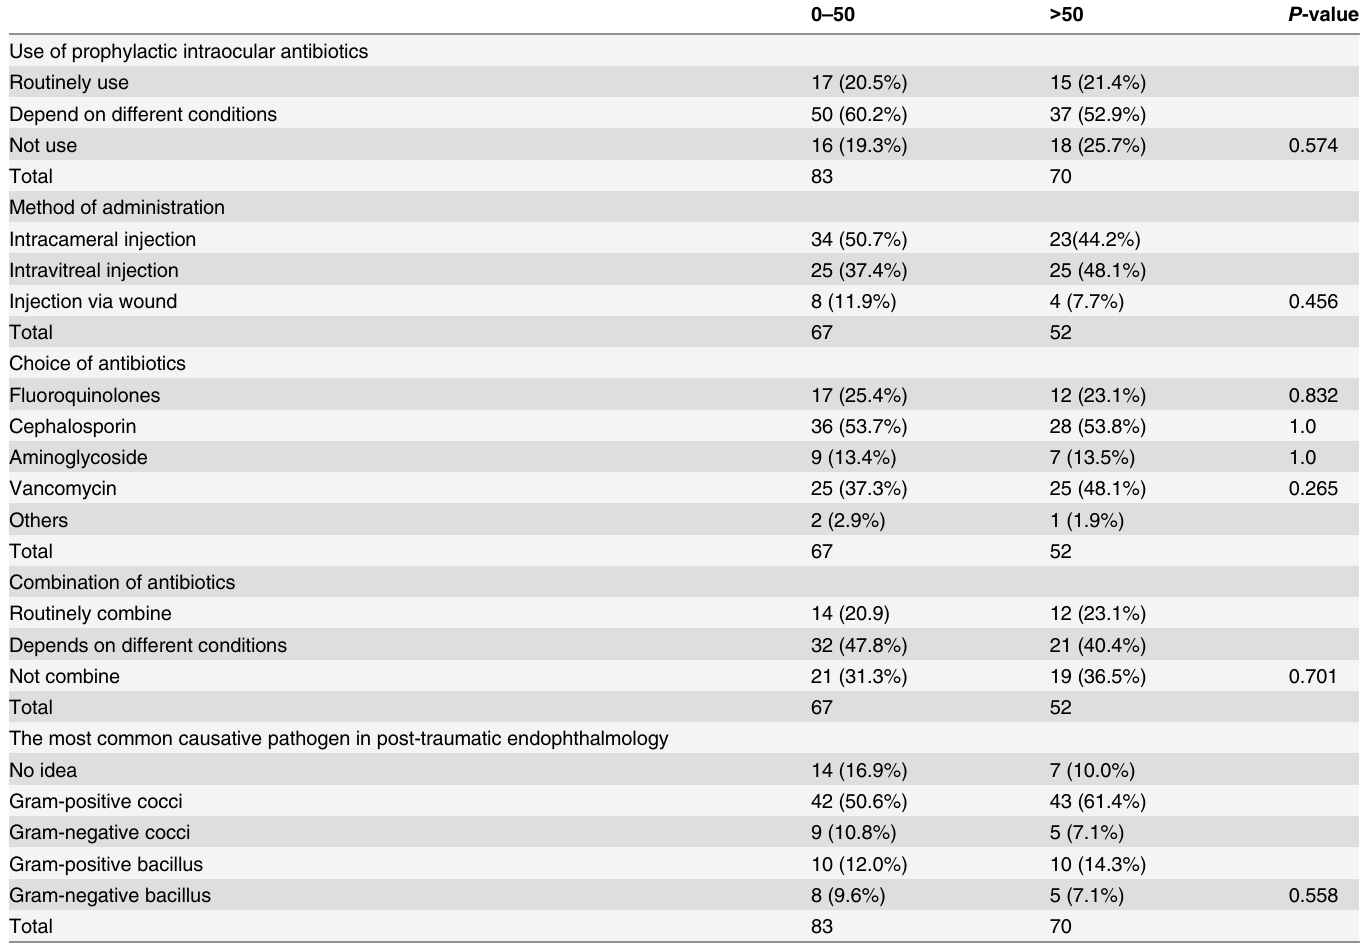
Table 7. Practice of intraocular antibiotics in open globe injuries and the annual eye repair